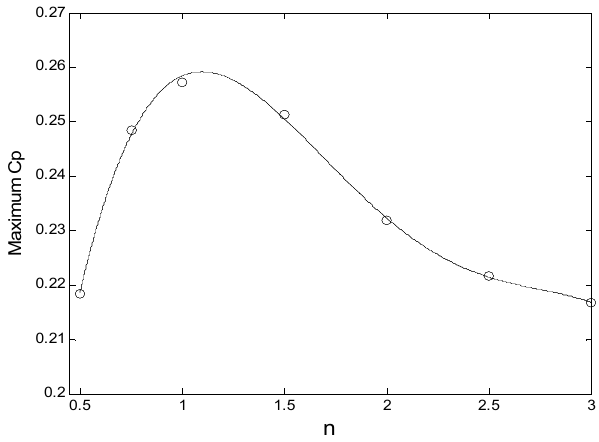
Figure 9. The maximum coefficient of power with respect to blade